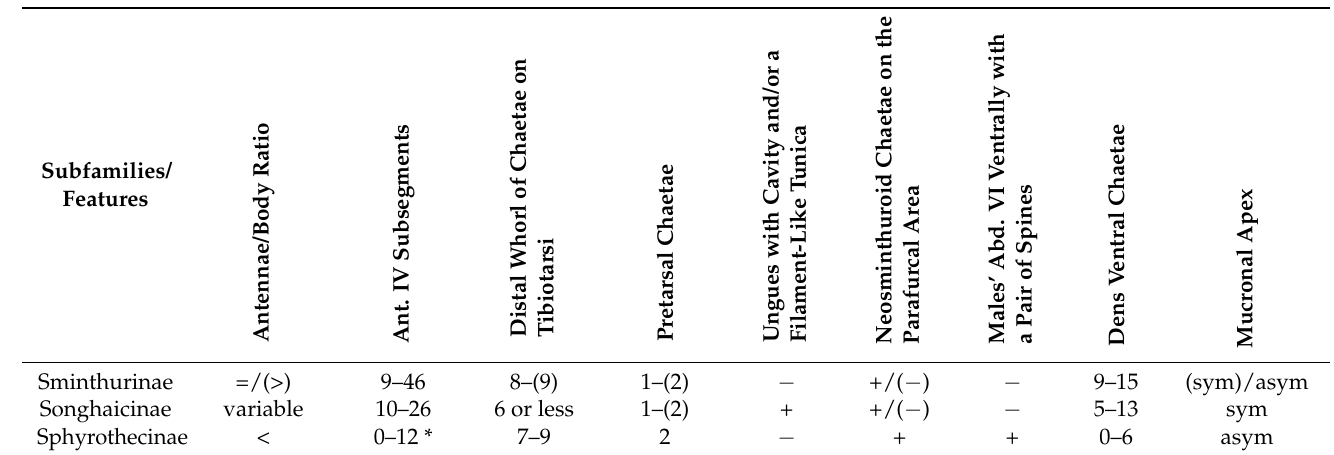
Table 1. Comparison between the subfamilies of